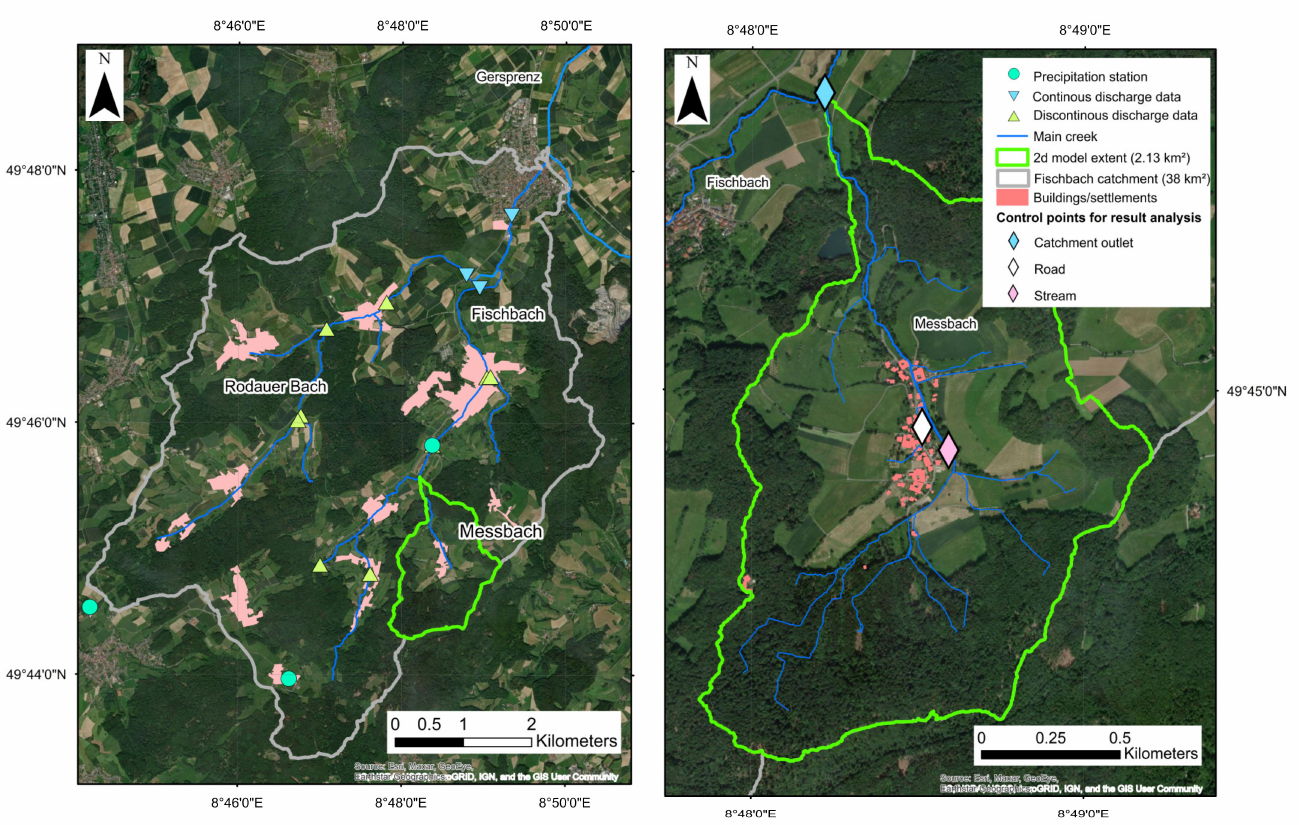
Figure 2. Study area of Messbach